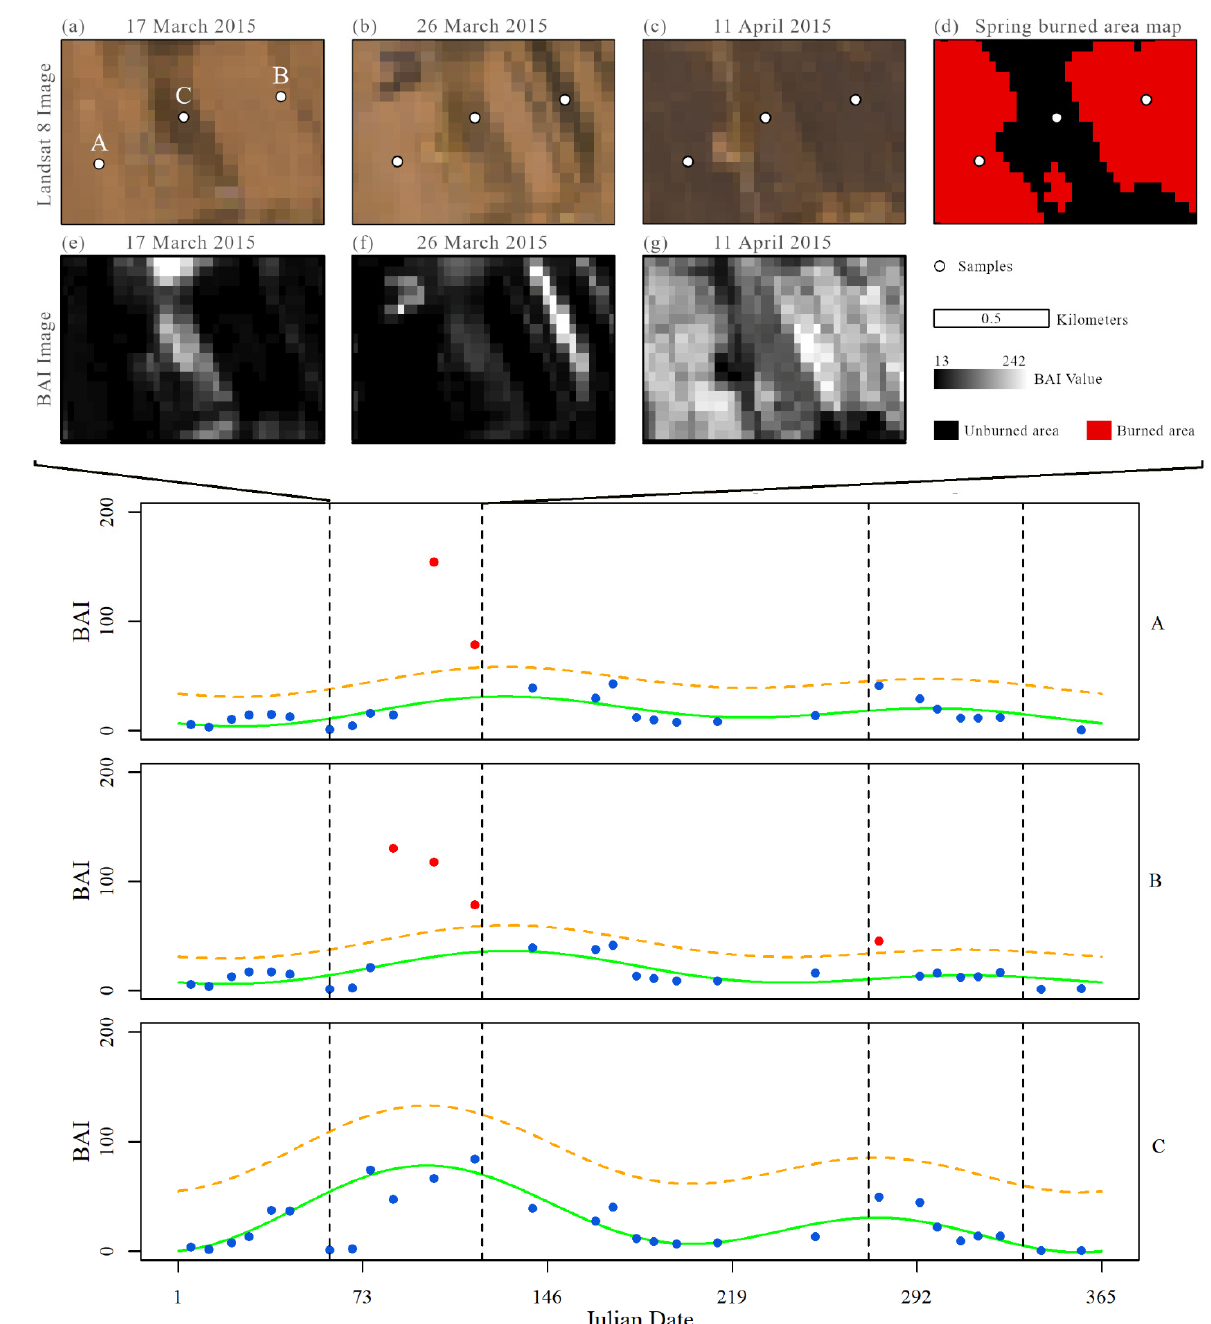
Figure 5. Demonstration of cropland burned area detection in the spring fire season. The three Landsat images are selected from the spring fire season with corresponding BAI images, and the spring burned area map is the cropland burned area detection result. The three multi-harmonic model fitting graphs below are corresponding to the three points A, B, and C, respectively.